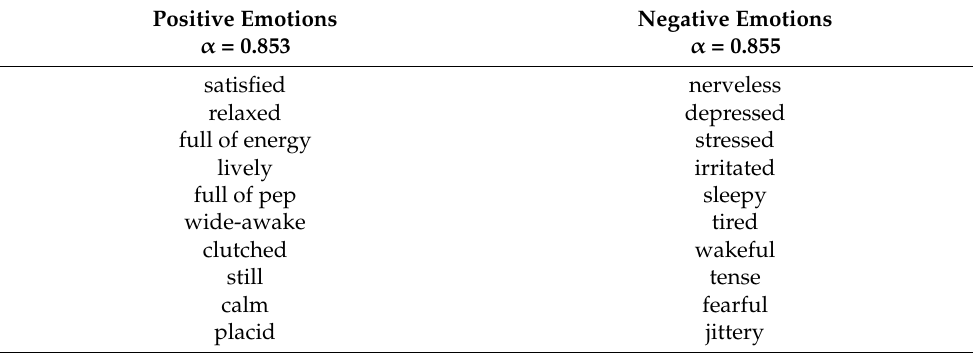
Table 1. Selected items of the questionnaire of this study including Cronbach’s α